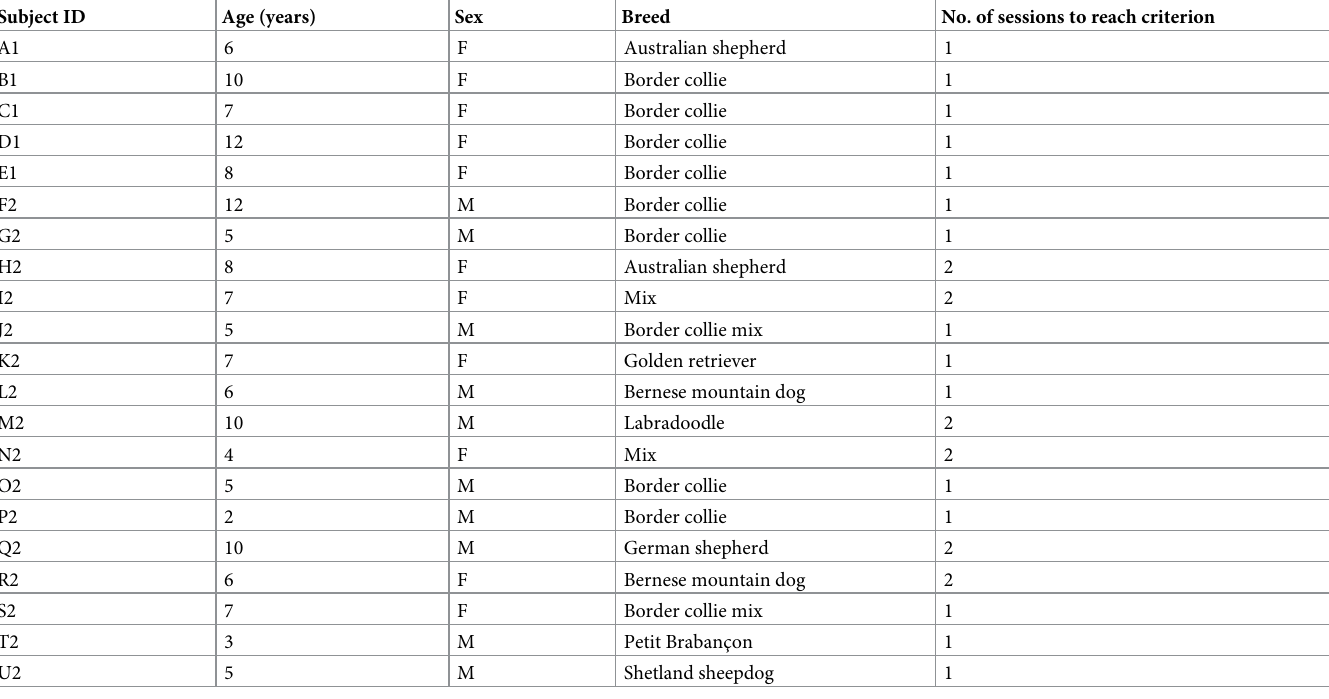
Table 2. Subject information including age, sex, breed, and the number of training sessions required to reach the